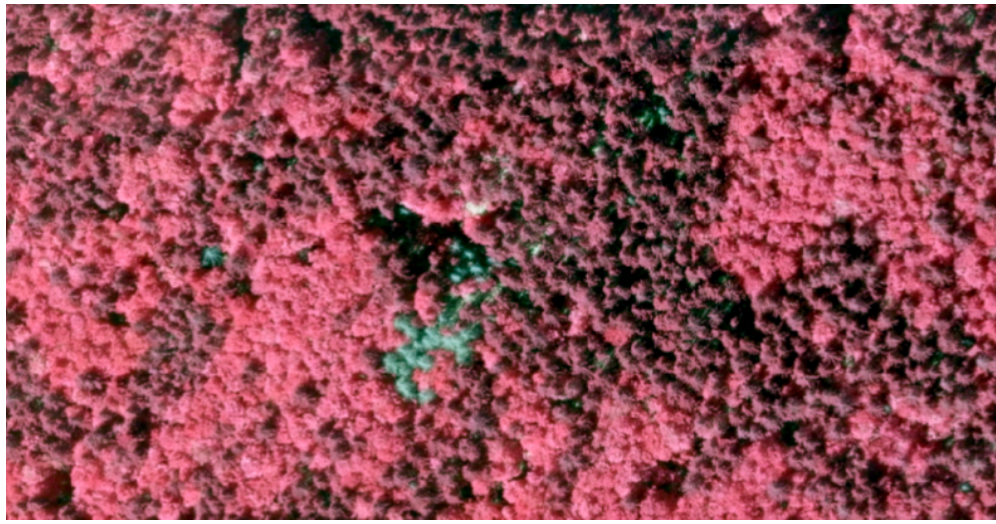
Figure 2. A forest scene in the color infrared aerial image with a ground pixel resolution of 20 cm. Standing dead spruce trees with crowns appear in gray, while the living trees are shown in red (broadleaf and coniferous trees). Table 1. Flight campaigns of multi wavelength airborne laserscanning (ALS)